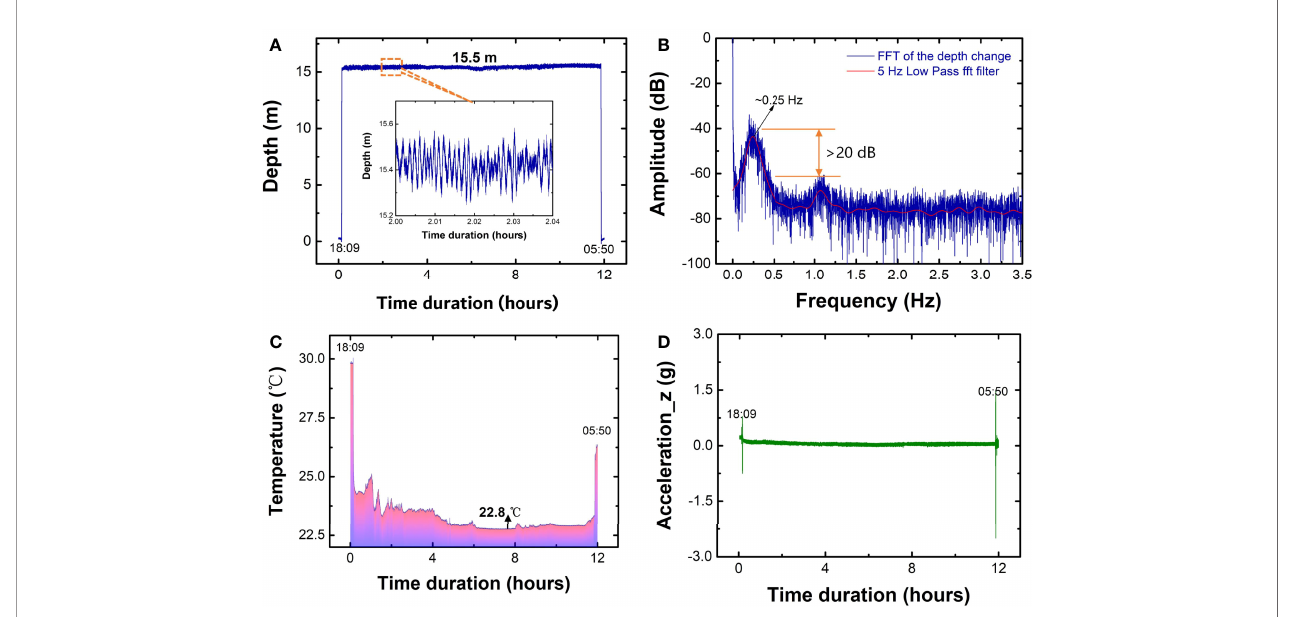
FIGURE 7 | Measured results of the depth, temperature, and acceleration in a time duration over 12 h under the sea. (A , C , and D) are the depth, temperature, and acceleration monitored in real time, and (B) is the fast Fourier transform of the depth change in the time